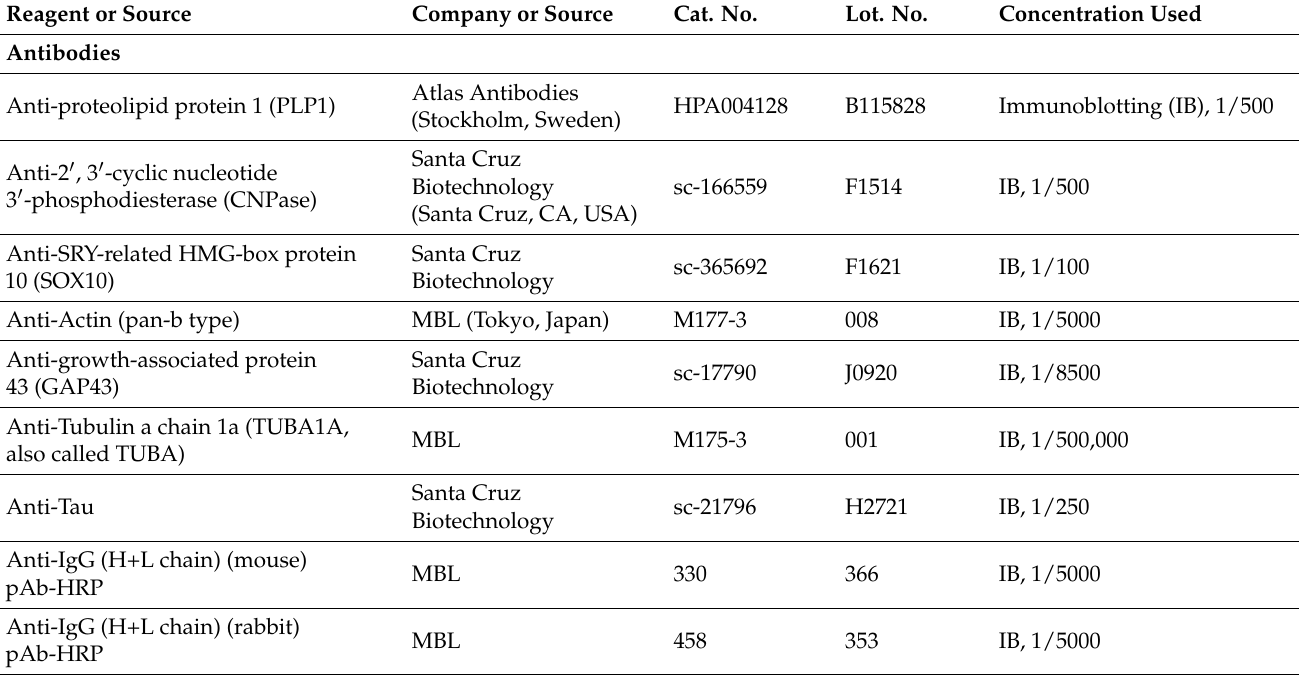
Table 1. List of antibodies.